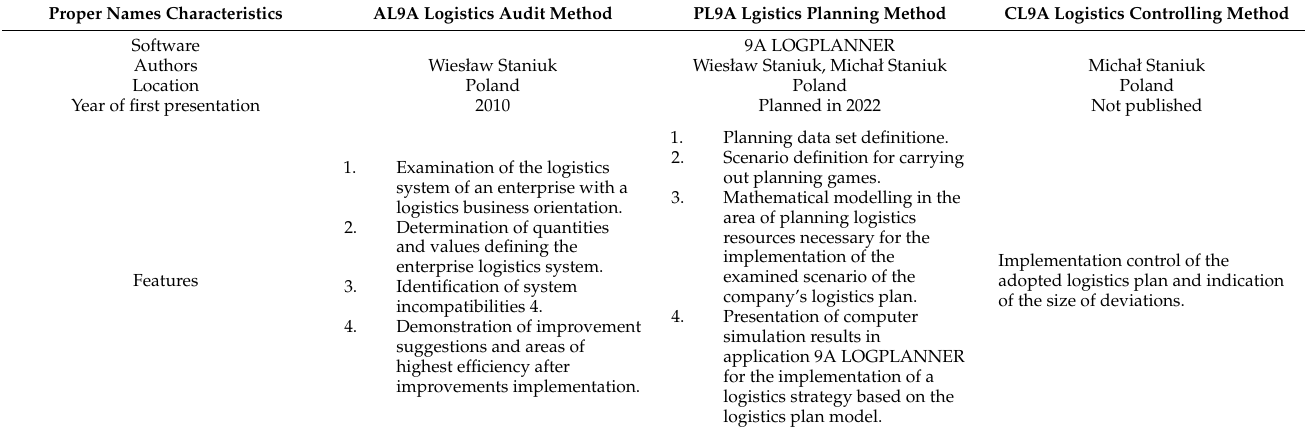
Table 3. Information on the proper names used in the article: AL9A, PL9A, CL9A, and 9A LOGPLANNER.